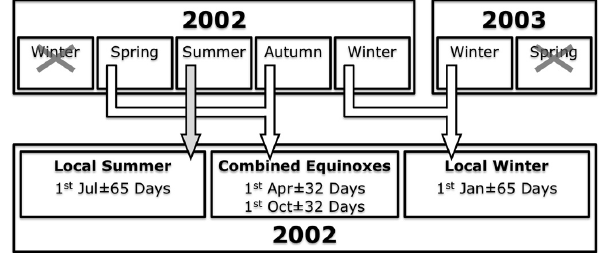
Fig. 2. The seasonal subdivision shown for the year 2002 in the Northern Hemisphere. Three seasons of about 130 days each are shown: local winter (1 January ± 65 days); combined equinoxes (1 April ± 32 days and 1 October ± 32 days); local summer (1 July ± 65